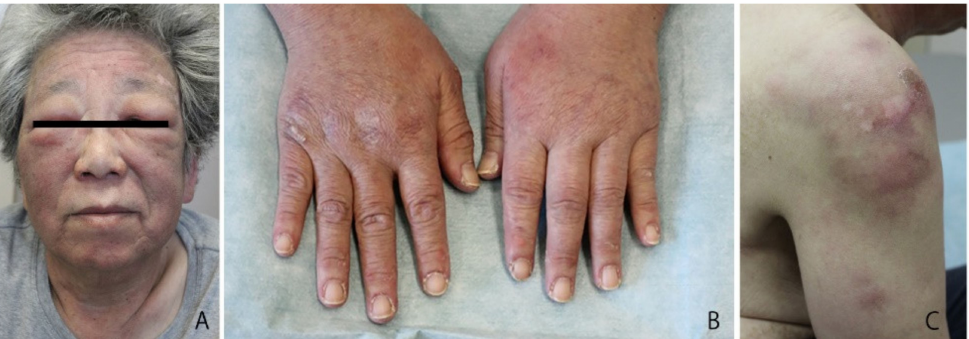
Figure 1. Presentation of the patient. ( A ) Facial edema and edematous eyelids; ( B ) scaly erythema on the dorsal surface of the digits; ( C ) subcutaneous nodules on the